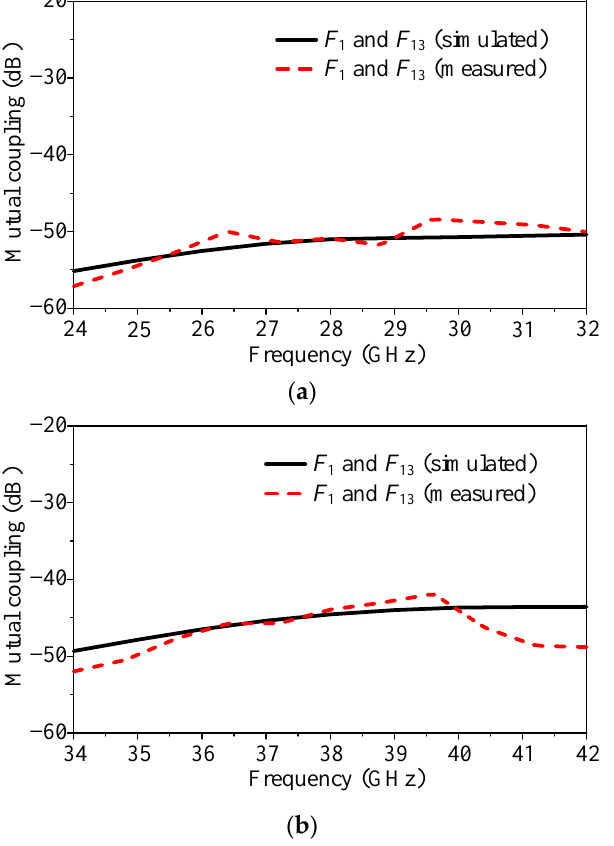
Figure 8. Mutual coupling of the millimeter-wave elements. ( a ) 28 GHz and ( b ) 38 GHz bands. Figure 9 illustrates the antenna efficiency and realized peak gain for each module.